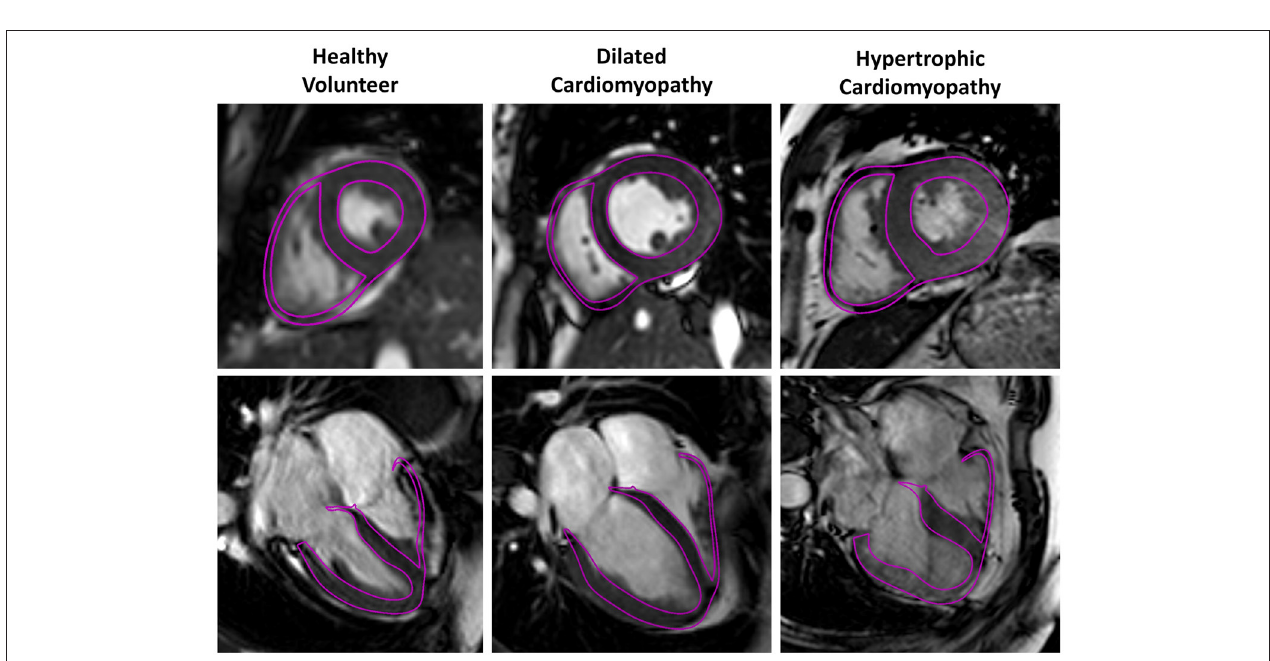
FIGURE 6 | Three representative cases for the healthy volunteer, DCM and HCM groups are shown below with models fit to the neural network segmentations. Model surfaces at end-systole (purple) are overlayed on a single long-axis and short-axis